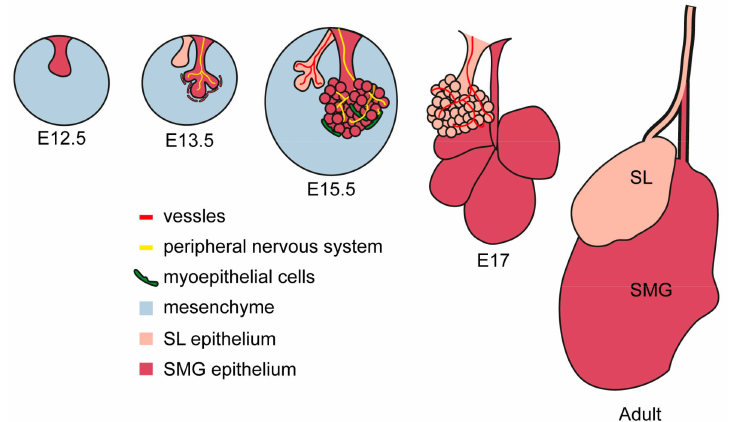
Figure 1. Embryonic development of murine SMG and SL glands. Embryonic development starts with an epithelial placode, which, in turn, invades the mesenchymal layer and branches up. Innervation and vascularization advance in parallel with the growth of salivary glands primordia and directly regulates its maturation. Myoepithelial cells arise from the external epithelial layer and develop into the contracting unit involved in the regulation of